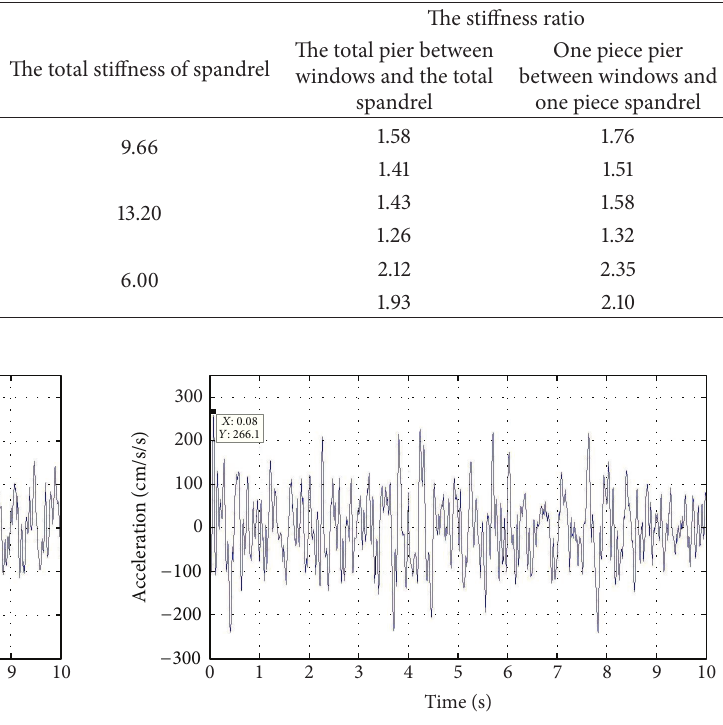
Figure 15: The time history curve of Lixian County ground motion in 𝑌 direction.